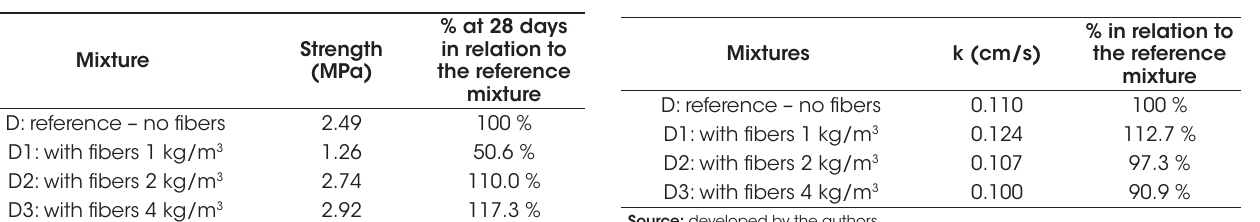
Flexural strength after the addition of fibers at 28 days Permeability of concretes with